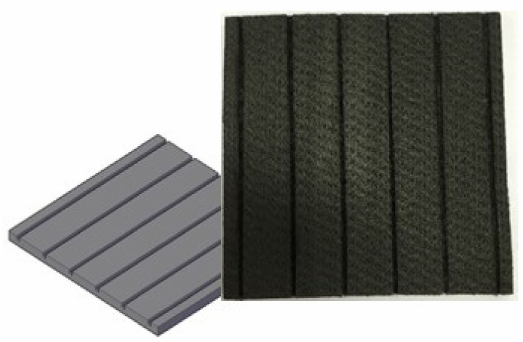
Figure 18. Flow channel design on the porous